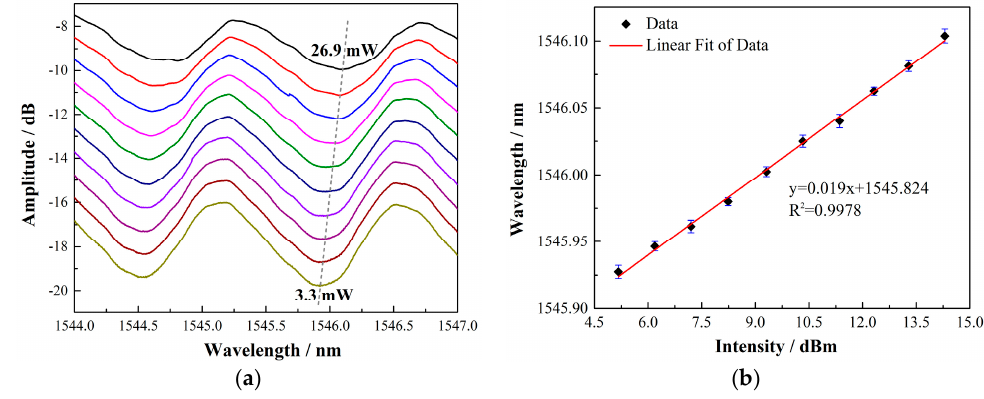
Figure 4. ( a ) Cladding modes evolution with different input powers. As the power increased, the wavelength showed a red shift. ( b ) The cladding mode wavelength shift with different input powers.